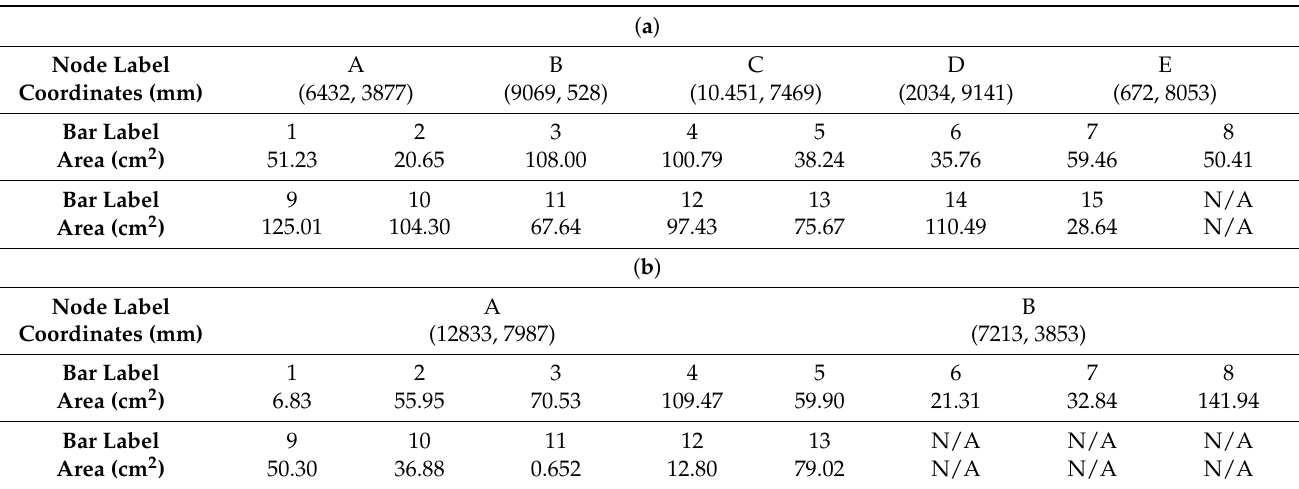
Table 8. Detailed data of the generated truss in experiment 2 with a different number of